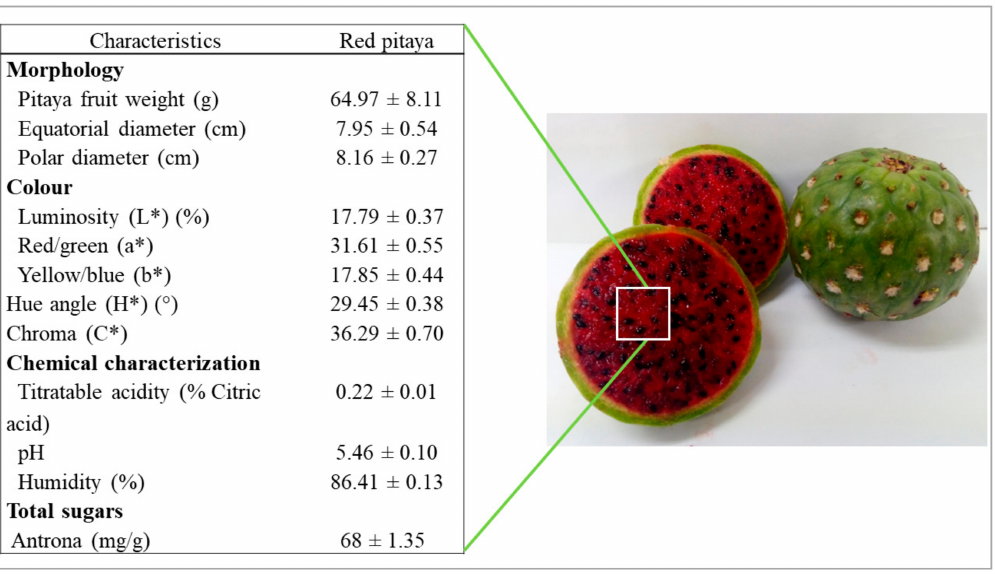
Figure 1. Physical-chemical composition of pitaya pulp ( Stenocereus thurberi